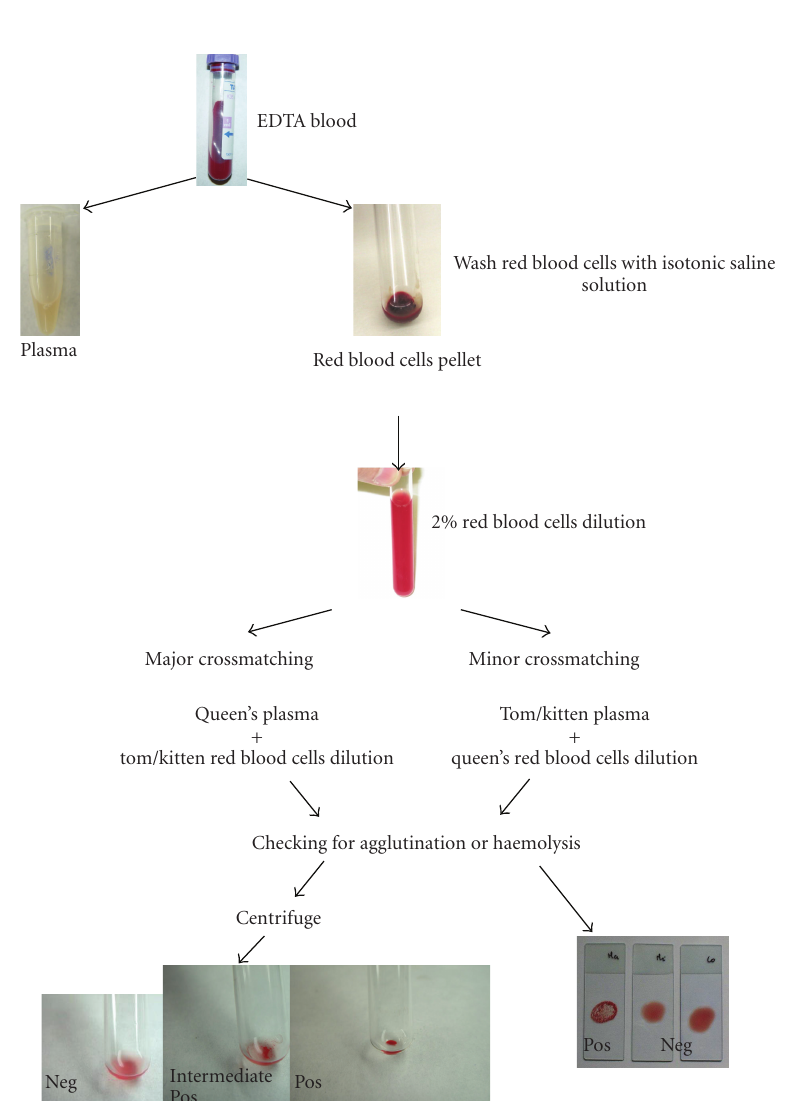
Figure 1: Crossmatching schematic representation. See Table 5 for procedure explanations. Crossmatching can also be performed as a slide test by using the same protocol. Haemolysis can better be recognized in the tube test when compared to slide method.